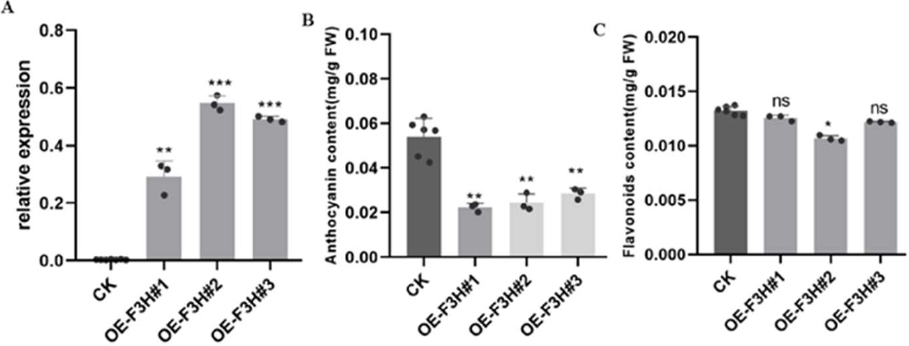
Figure 5. Overexpression of MazsF3H in tobacco: ( A ) Expression levels of MazsF3H in overexpression transgenic tobacco plants. ( B ) Anthocyanin content in overexpression transgenic tobacco plants. ( C ) Flavonoid content in overexpression transgenic tobacco plants. The significance is marked